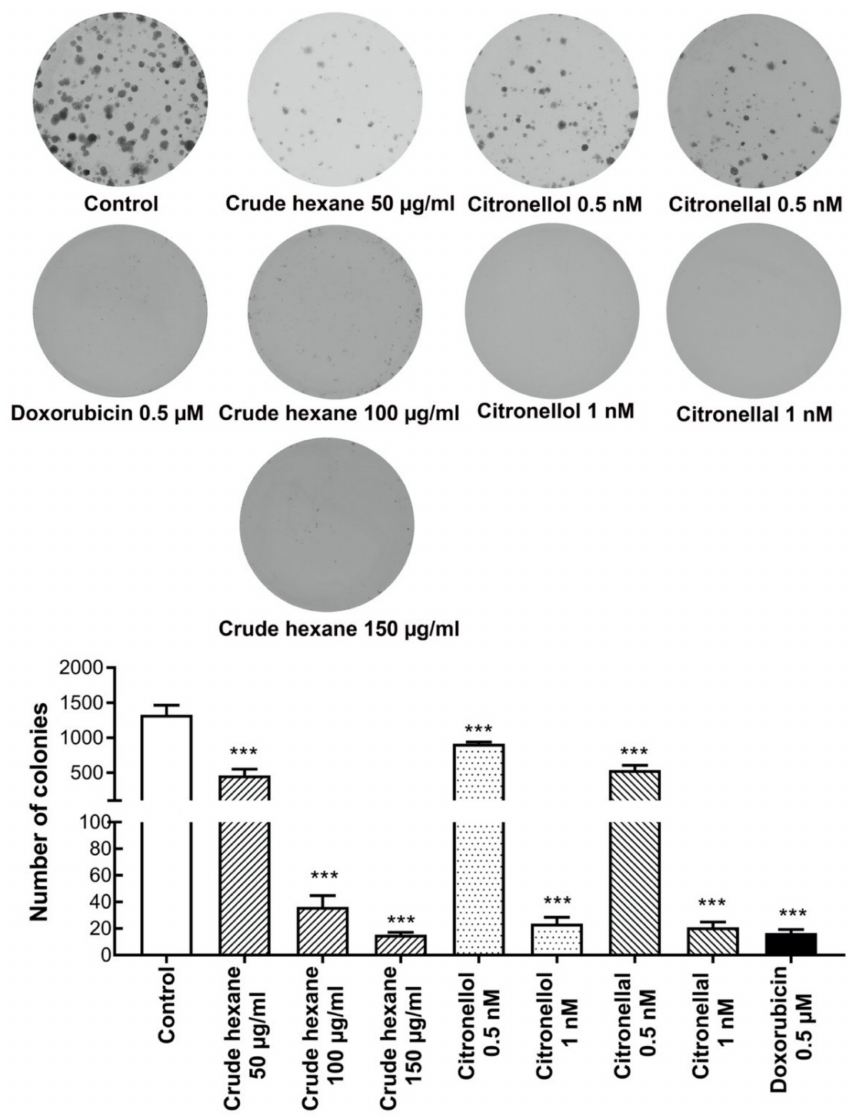
Figure 4. Colonies picture as 8-bit grayscale images under di ff erent treatments. Crude hexane, citronellol, and citronellal reduced number of MDA-MB-231 cell colonies in a dose-dependent manner. Data are presented as means ± SEM. One-way ANOVA with Dunnett’s multiple comparisons test was used to analyze the di ff erence between control and treatment groups, p value < 0.05 considered significant (*** p <